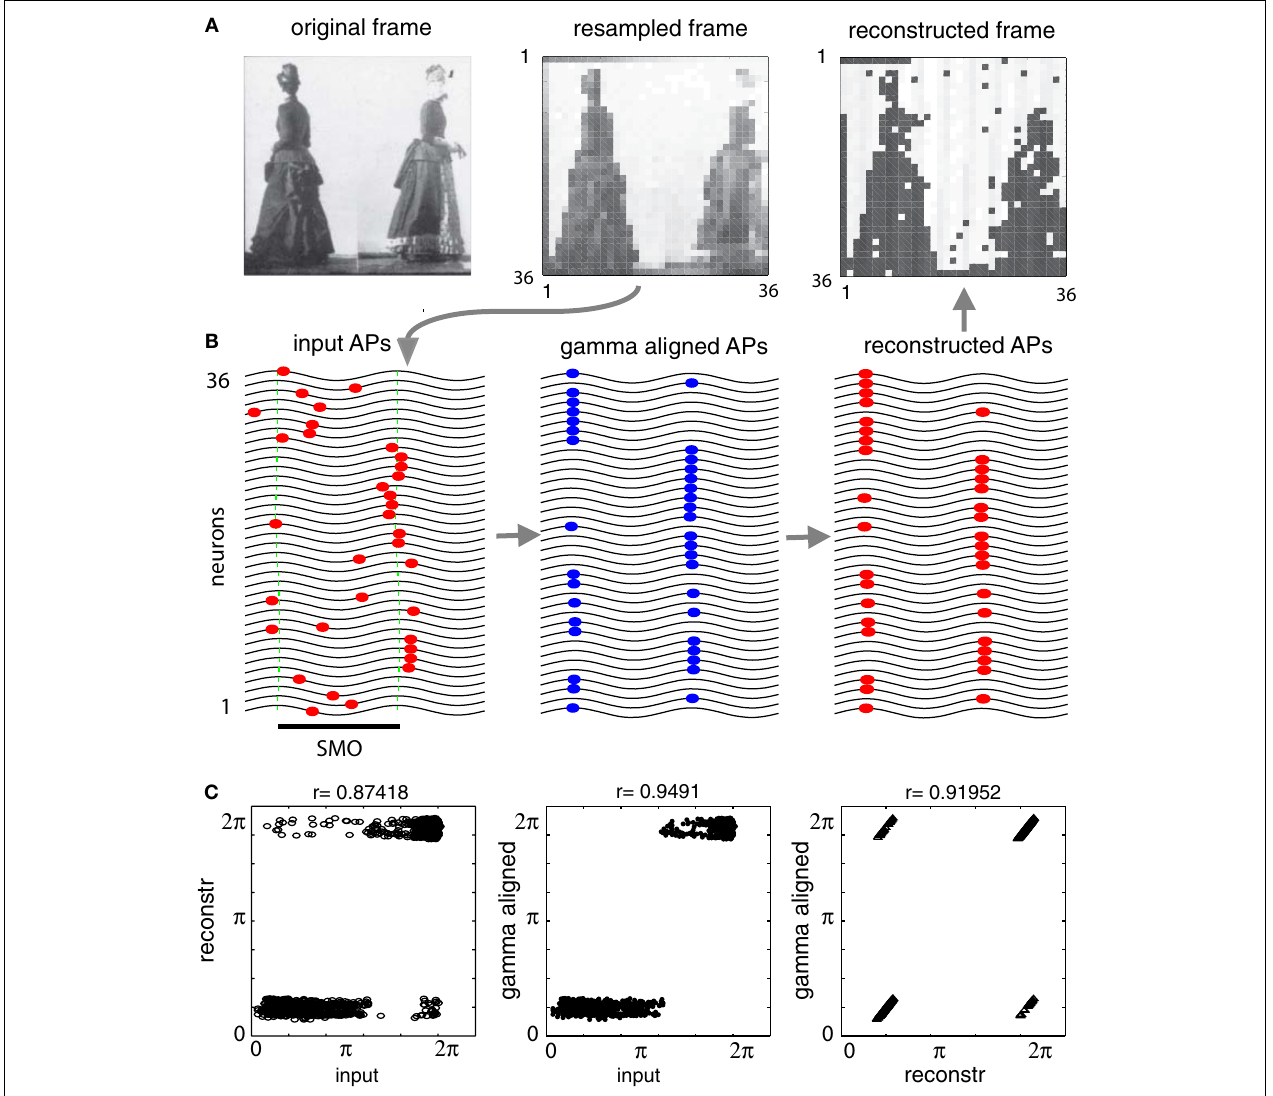
represent the ongoing SMO per neuron. Scale bar indicates one SMO period. (C) Correlations between the latency-encoded input and the reconstructed AP times (left); between the latency-encoded input and the aligned APs (middle); and between the aligned APs and reconstructed APs (right). Correlation values are shown on the top. Note that most of the variances derive from the alignment to SMO. Time units are relative to the length of an SMO